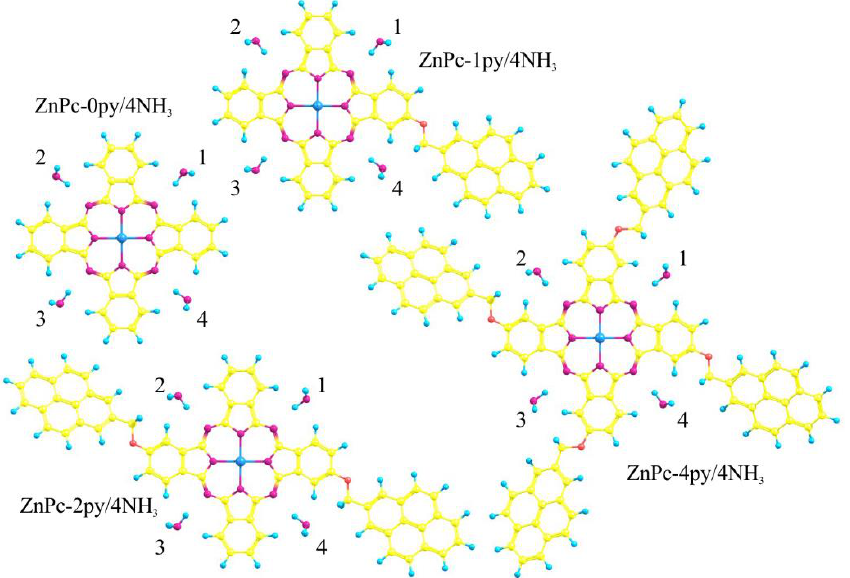
Figure 2. Geometrical structures of ZnPc- x py/4NH 3 aggregates, obtained from the results of quantum-chemical calculations by the DFT BP86-D3/def2-SVP method. The numbers 1–4 indicate the order of calculation of the binding energy of the corresponding NH 3 molecule in the composition of the entire aggregate.